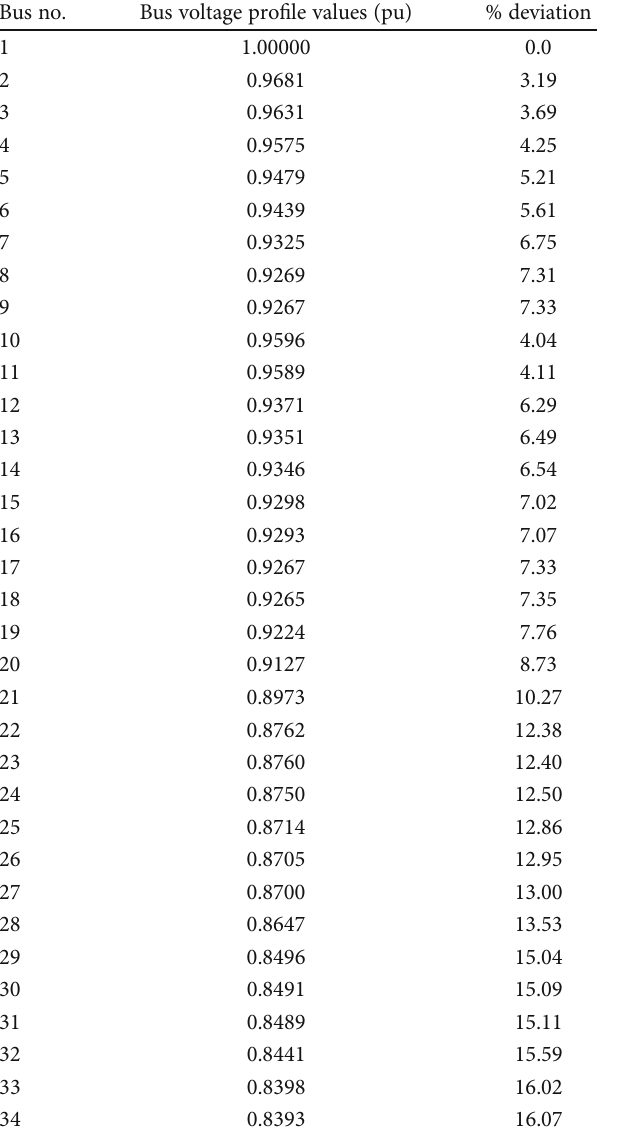
Table 5: Base case power losses. Table 4: Base case voltage pro fi